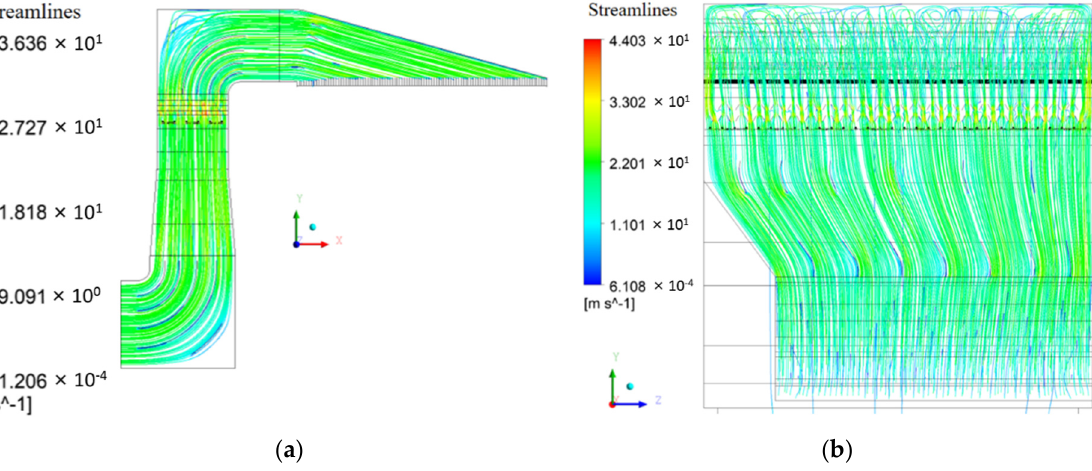
Figure 9. Contours of the flow distribution of Scheme 1 and Scheme 4.4 for the cross-section Z = − 5: ( a ) Scheme 1; ( b ) Scheme 4.4.